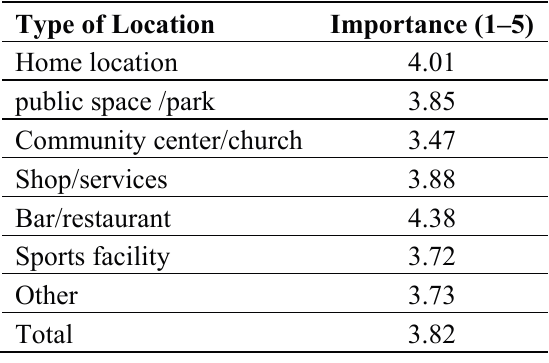
Table 3. Mean importance of interactions per location